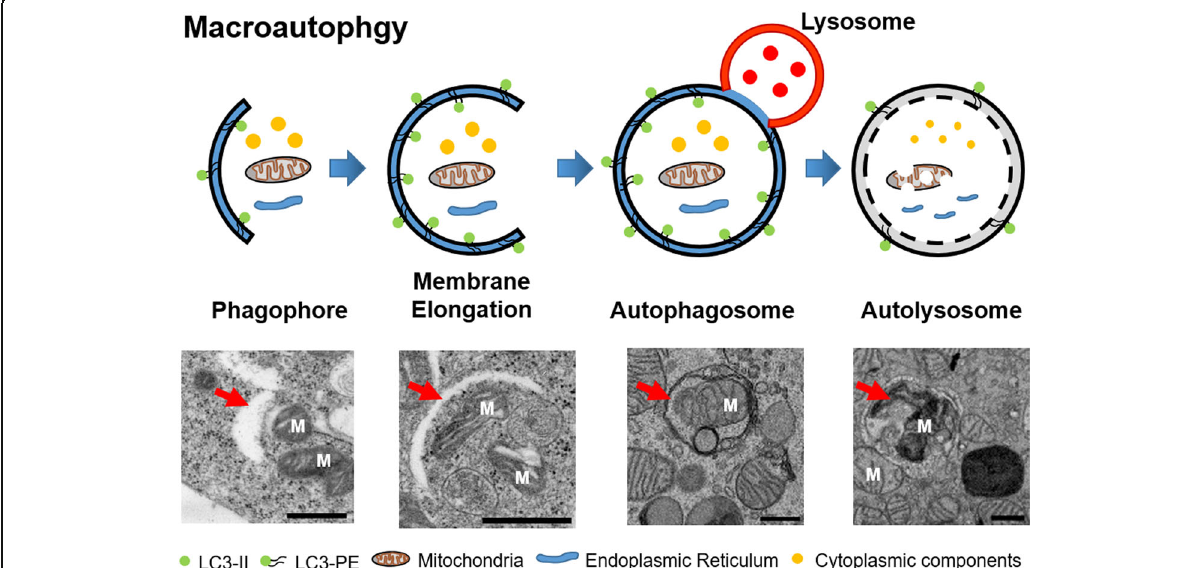
Fig. 1 Schematic model and transmission electron microscopic image of macroautophagy. Autophagy is a multi-step process including four main processes, which is isolation of membrane, vesicle expansion, maturation and lysosome fusion, and degradation of compartments. M: mitochondria, scale bar: 500